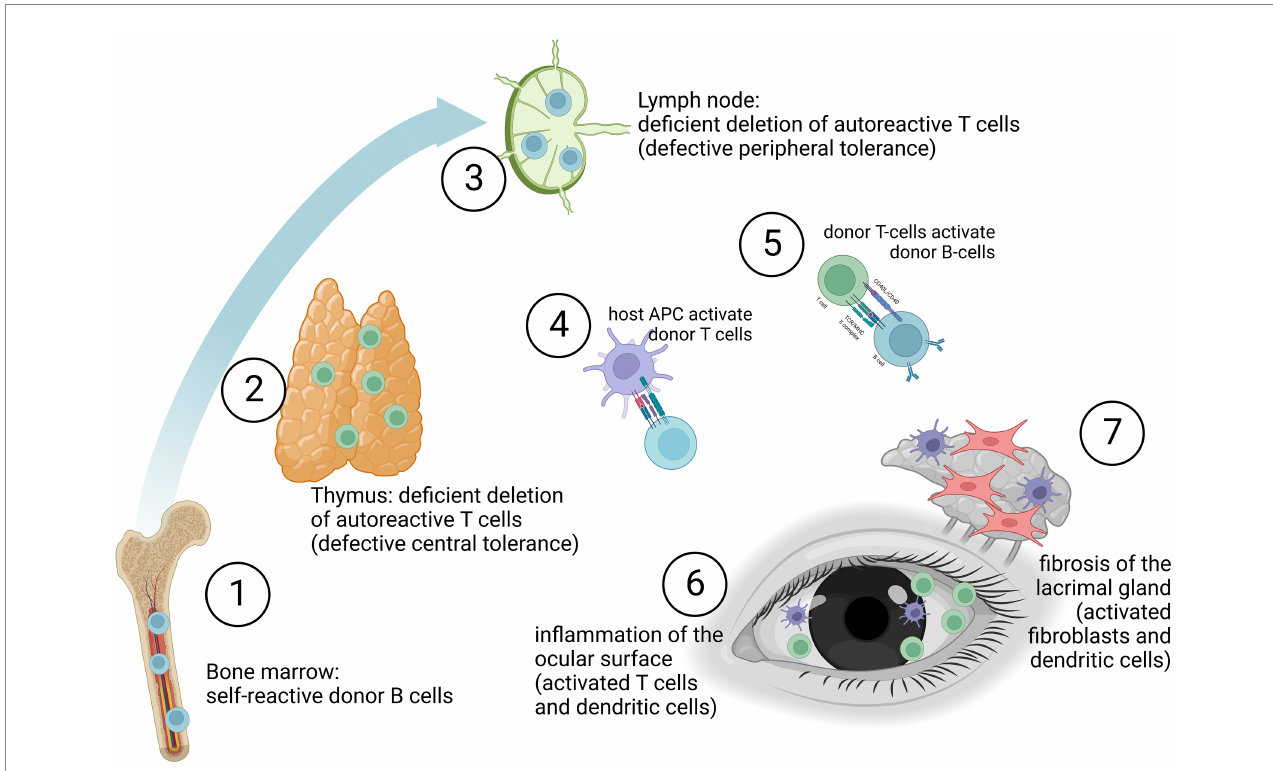
FIGURE 1 Graft-versus-host disease may be due to self-reactive donor B cells (1), deficient deletion of autoreactive donor T cells in the thymus (2) or deficient deletion of autoreactive donor T cells in the lymph nodes (3). Especially antigen-presenting cell (APC) driven activation of donor T cells (4) but also B cells (5) lead to an inflammation of the ocular surface (6). Furthermore, activation of fibroblasts by APCs (e.g., dendritic cells) induces fibrosis of the lacrimal gland (7). (The figure was created with